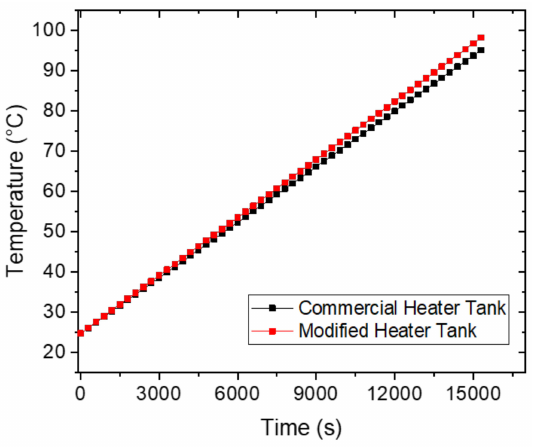
Figure 6. Temporal variation of water temperature for tanks with the same capacities and different